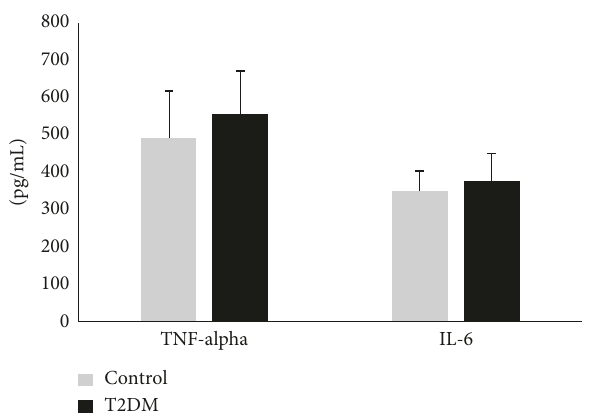
Figure 1: Salivary TNF- α and IL-6 in T2DM: Unstimulated whole saliva (UWS) was collected from 20 T2DM individuals and 20 healthy individuals. Each UWS sample was depleted of amylase and immunoglobulins. Precleaned UWS was assessed for TNF- α and IL-6 using specific sandwich ELISA kits.